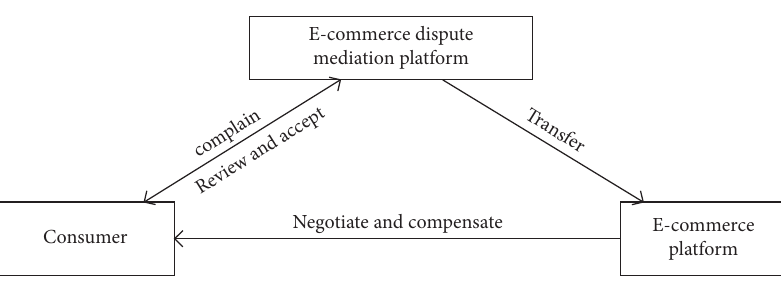
Figure 1: Flow chart of multisubject complaint